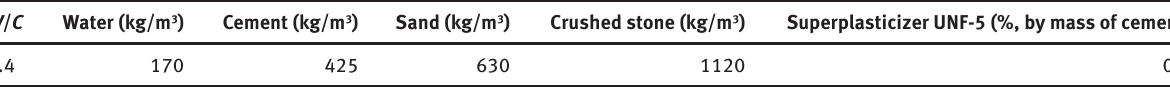
W/C represents water-to-cement